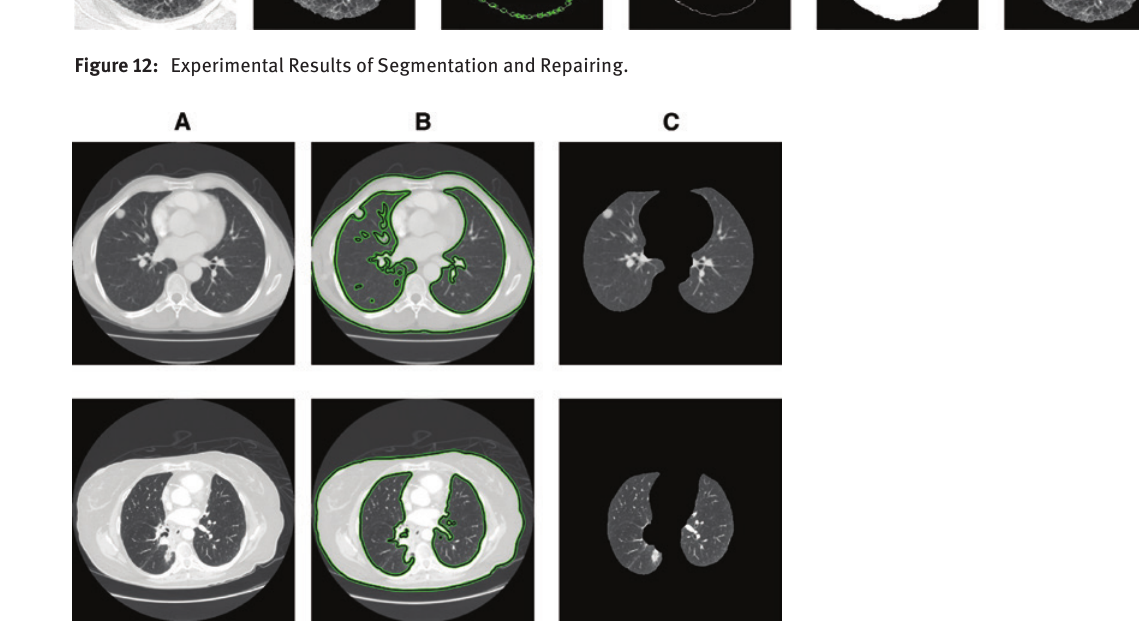
Figure 13: Segmentation Results Comparison between the (A) Input Thoracic CT Images, (B) Active-Contour Method and (C) Pro- posed